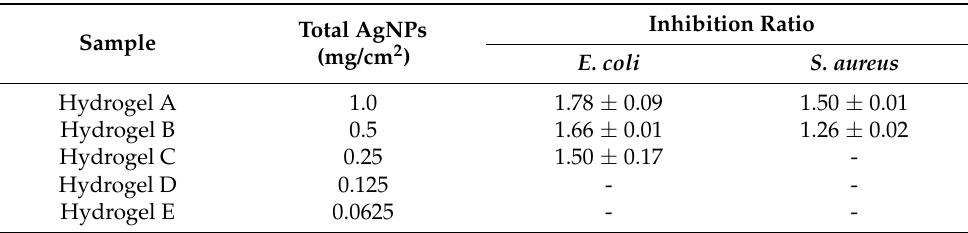
Table 2. The inhibition ratios of the AgNP-loaded hydrogels against E. coli and S. aureus . The data are represented by the mean ± standard deviation from 3 replicates, each measured in 3 directions. The dash indicates the absence of a clear zone.